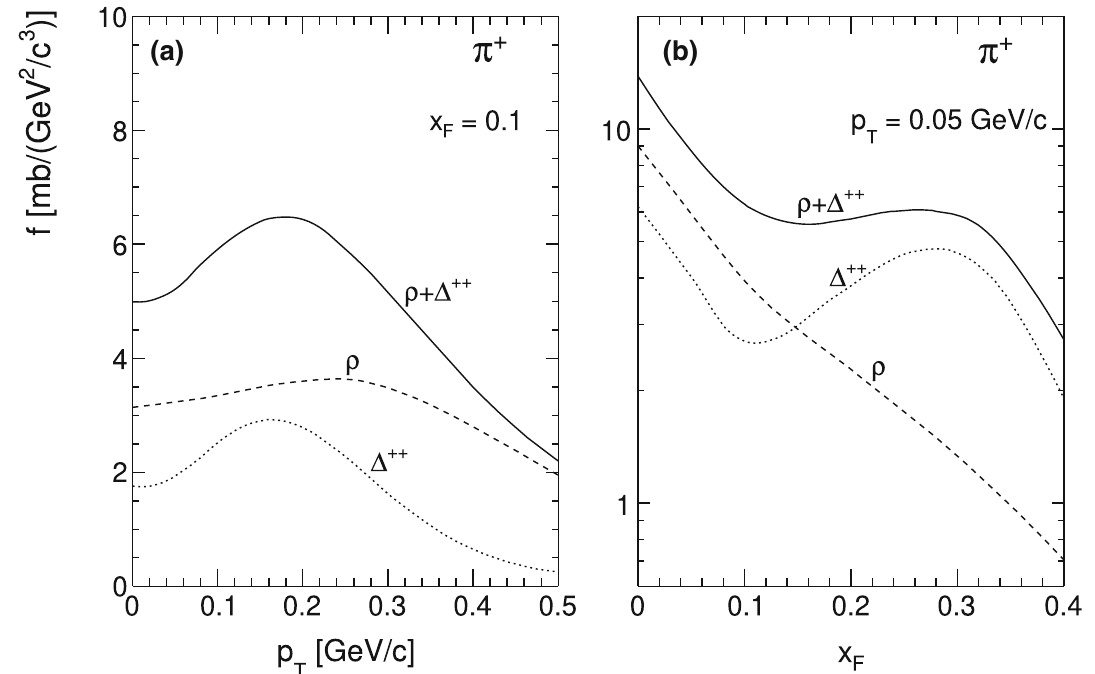
Fig. 85 Monte Carlo study of a p T distribution at fixed x F , b x F distribution at fixed p T for π + resulting from ρ and Δ ++ decay, NA49